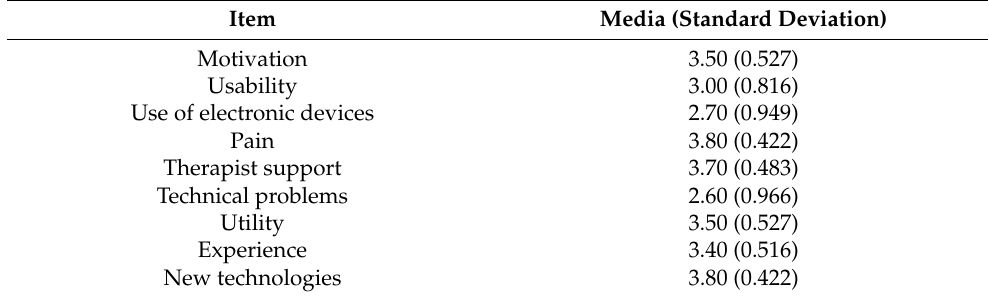
Table 2. Patients’